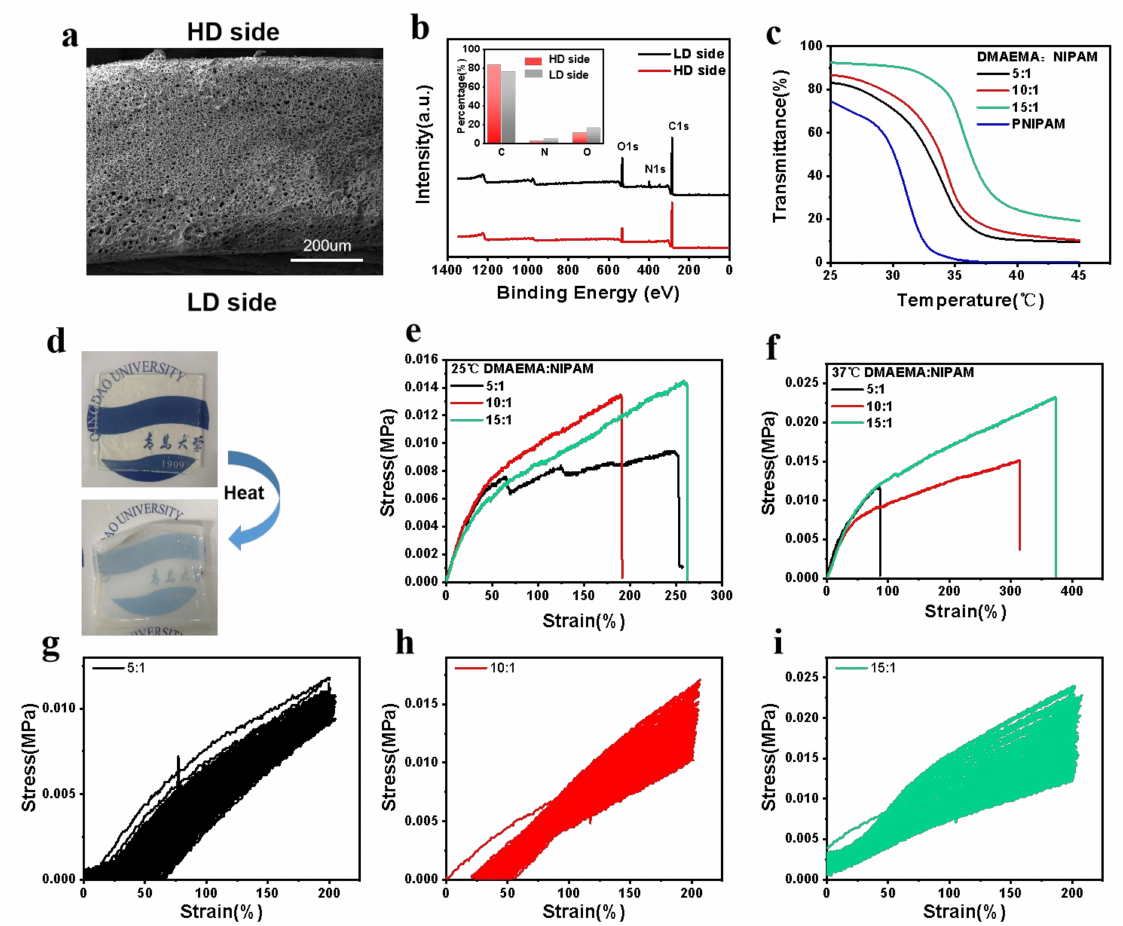
Figure 2. Characterization of the self-powered gradient hydrogel. ( a ) Cross-sectional SEM images of the gradient PDMAEMA/PNIPAM hydrogel. ( b ) Wide-scan survey XPS spectra of the HD side and LD side for the gradient PDMAEMA/PNIPAM hydrogel, and the insert is the atomic percentage of carbon, nitrogen, and oxygen at the HD side and LD side. ( c ) Transmittance vs. temperature for the LCST-type hydrogels with different monomer mass ratios (DMAEMA/NIPAM). ( d ) The optical images of hydrogel at room temperature and after heating. ( e ) Stress–strain curves of the hydrogel with different DMAEMA/NIPAM mass ratios at room temperature. ( f ) Stress–strain curves of the hydrogel with different DMAEMA/NIPAM mass ratios after heating. Stress–strain cycle curves of hydrogels with different concentrations. ( g ) DMAEAM:NIAPM = 5:1, ( h ) DMAEAM:NIAPM = 10:1, ( i ) DMAEAM:NIAPM =